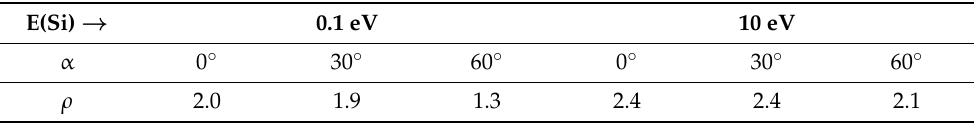
Table 1. Density of the deposited films ρ (g/cm 3 ), α is the deposition angle, E(Si) is the energy of the deposited silicon